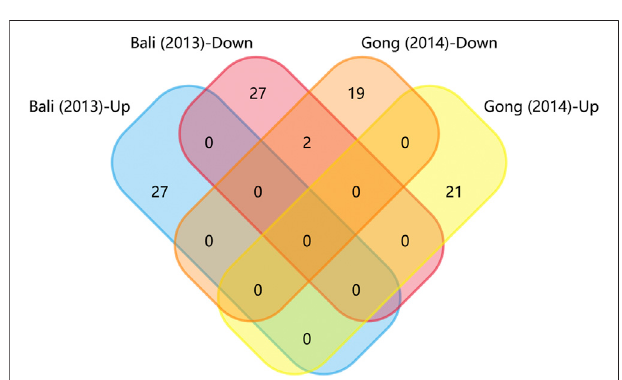
FIGURE 3 | Matrix table analysis for miRNAs expression pro fi les of disease-induced NP models. The number and percentage of co-regulated miRNAs were highlighted. The two overlapping miRNAs are miR-466i-3p and